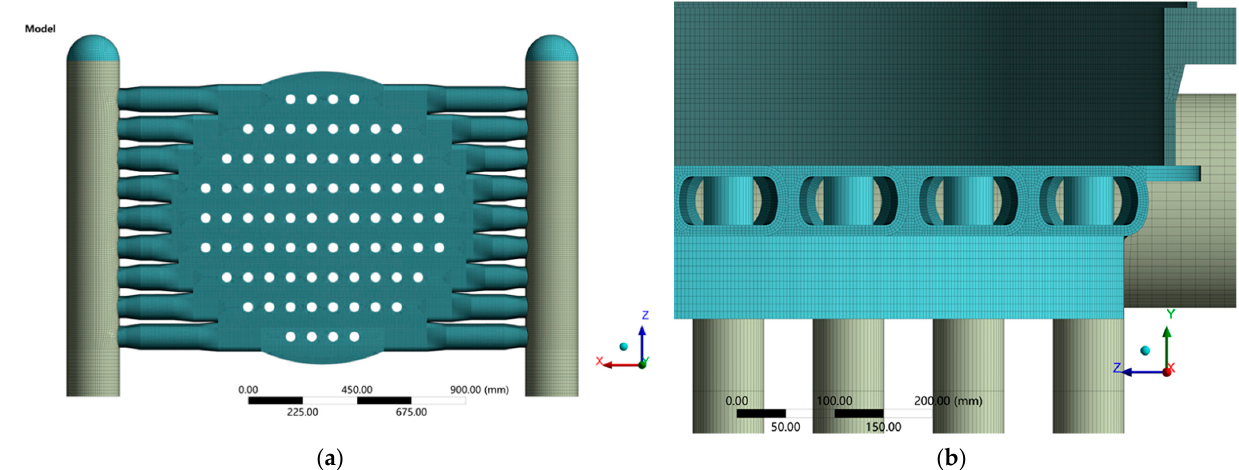
Figure 2. ( a ) Grid model of the flat-round tubesheet and collector headers. ( b ) Grid model of the connection zone of the flat-round tubesheet, heat exchange tubes and jacketed